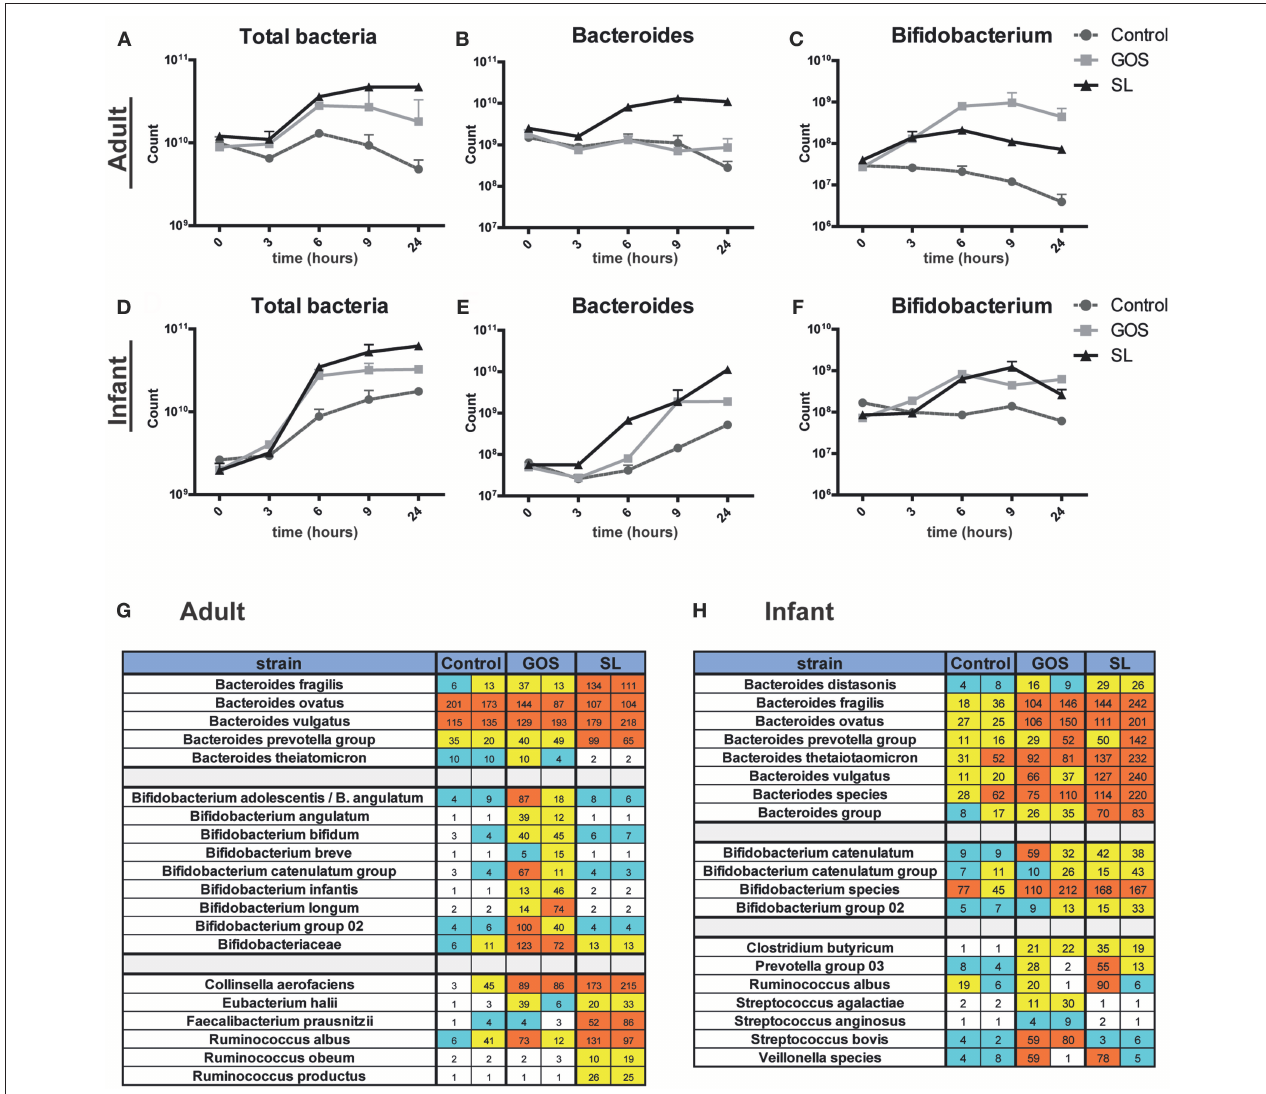
FIGURE 3 | SL and GOS differentially modulate microbiota composition. Batch cultures of adult and infant pooled fecal samples cultured in growth medium were supplemented with or without SL or GOS in duplo. Fecal samples were collected at the start of the batch culture and after 3, 6, 9, and 24h. Microbiota composition on genus level (A–F) and on species level (G,H) was determined by qPCR and chip analysis, respectively. Bacterial numbers were shown as mean ± SEM of two independent batch cultures. Raw fluorescence data are shown for both individual runs for chip analysis.